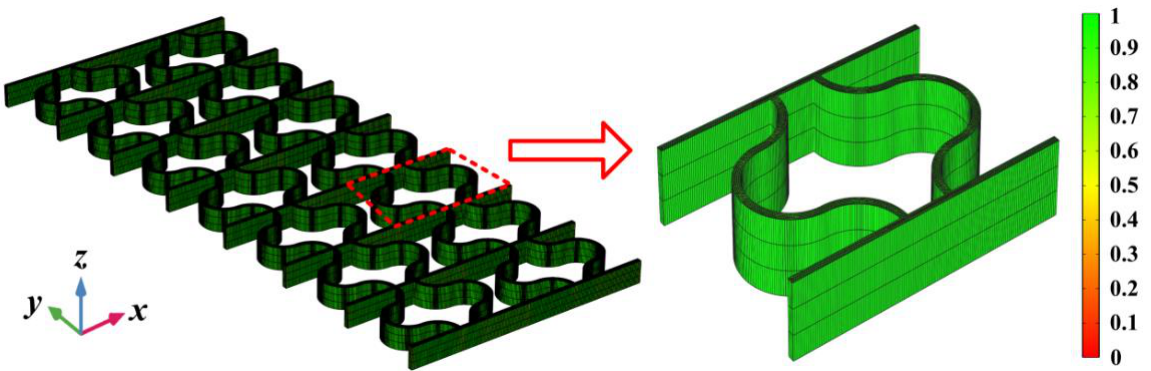
Figure 2. Finite element meshes of the active SMA honeycomb array.